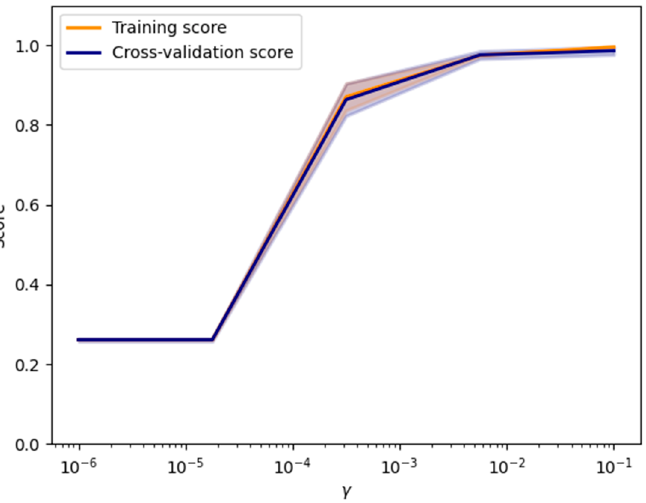
Figure 3. Training and validation curves using SVM with different kernel coefficient values. Note: For each coefficient value, the grey field of the validation score is formed based on the lowest and highest scores of the 10 folds.